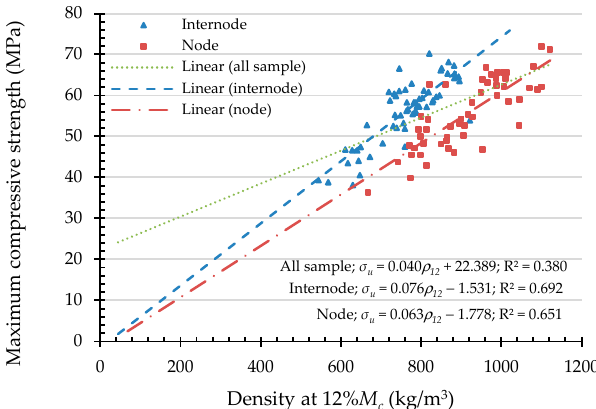
Figure 14. The simple linear regression analysis of bamboo maximum compressive load ( F u ) with linear mass at 12% M c as an indicating property.